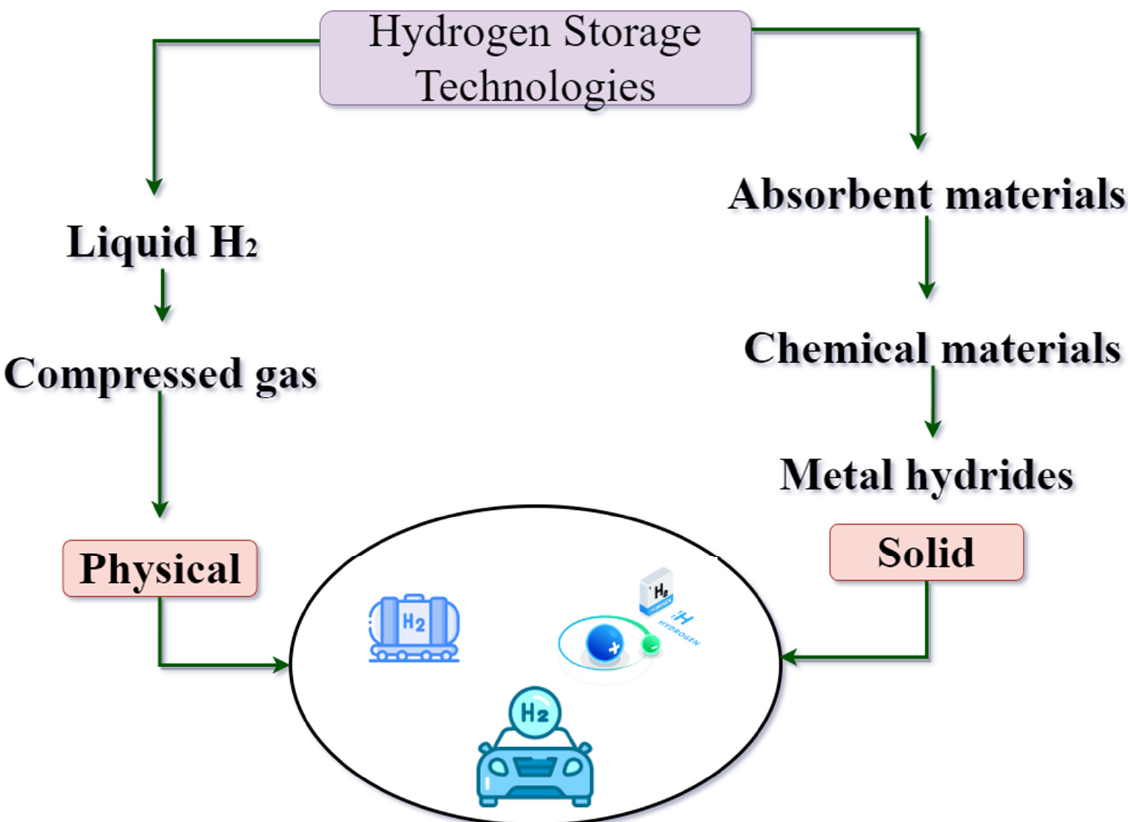
Figure 12. Hydrogen storage technologies.